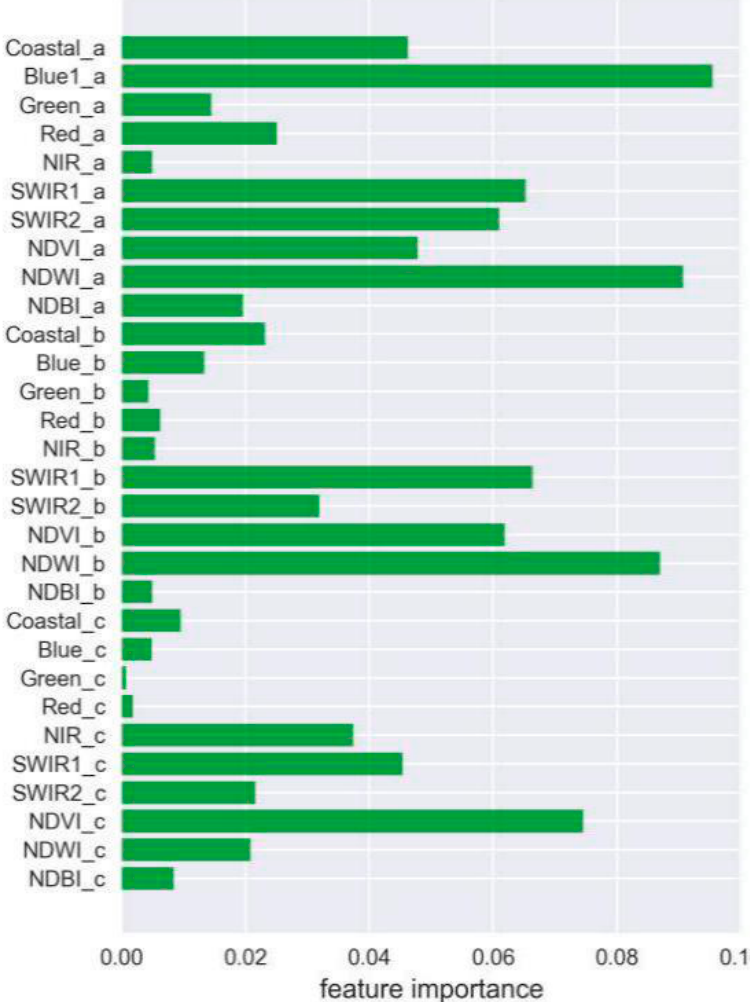
Figure 10. The feature importance with all 30 predictor variables in Beijing (( a ), ( b ), and ( c ) represent the results from ee.Reducer.min(), ee.Reducer.median(), ee.Reducer.max(), respectively. Coastal, Blue, Green, Red, NIR, SWIR1, SWIR2, NDVI, NDWI, and NDBI indicate the variables used in this study).